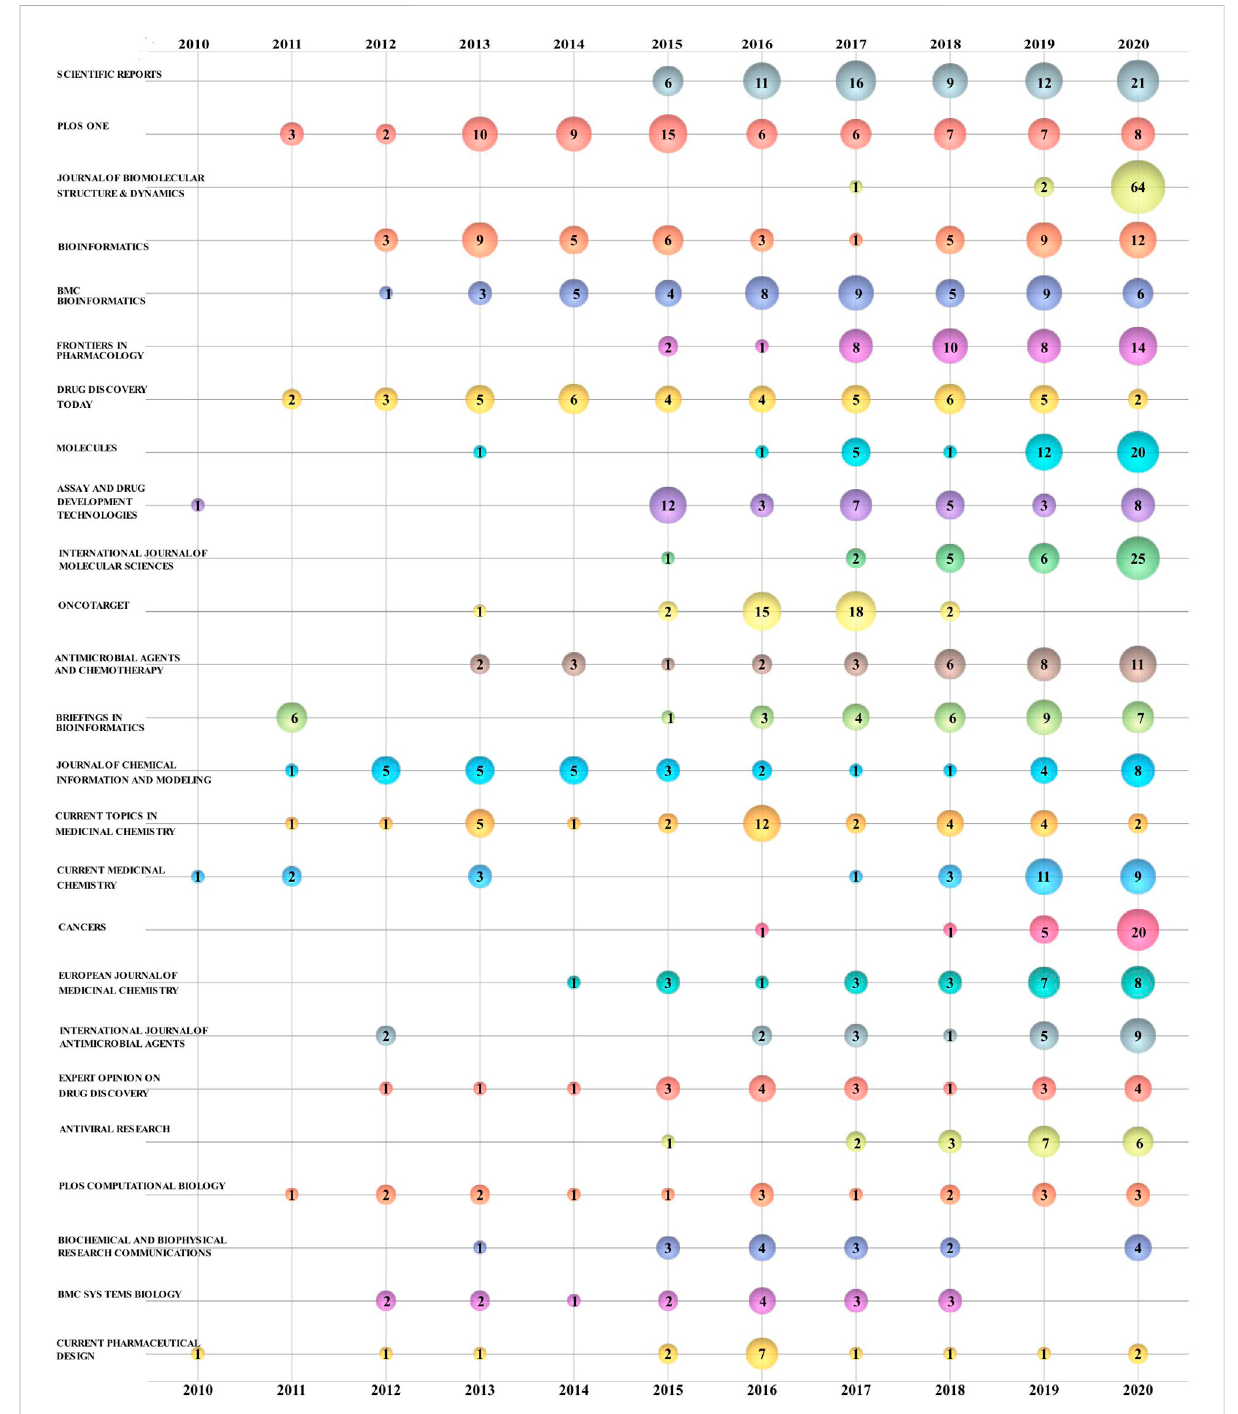
FIGURE 6 Bubble chart of the top 25 drugs repositioned by year in terms of journal